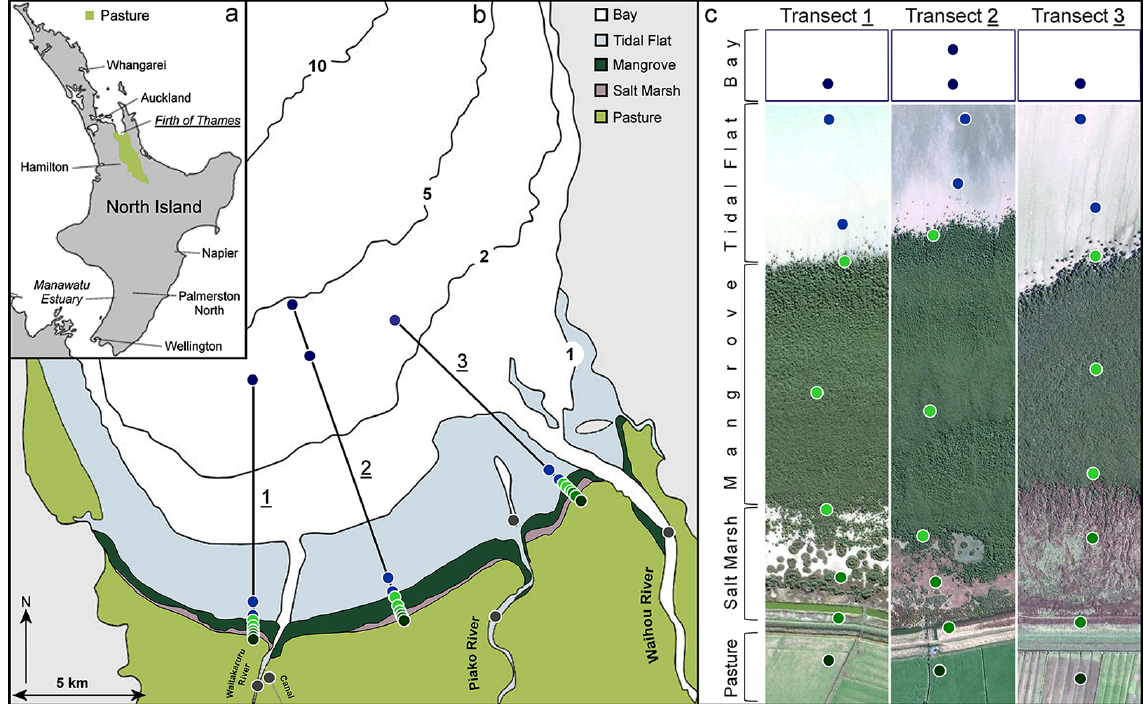
Figure 1. Study area. (a) Location of the Firth of Thames, North Island, New Zealand. The area of the catchment area, which is predominantly used for pastoral agriculture (1.3 million ha), is shown in green. (b) Firth of Thames transects across different ecosystems. (c) Plots ( n = 28) along transects were located in the following ecosystems: bay (dark blue), tidal flat (blue), mangrove (light green), salt marsh (green) and pasture (dark green). Tidal flat plots close to mangrove forests included mangrove seedlings. Five additional plots were located at rivers (grey). Isolines indicate elevations in metres below mean sea level. Google Earth images for areas from pasture to tidal flat in (c)